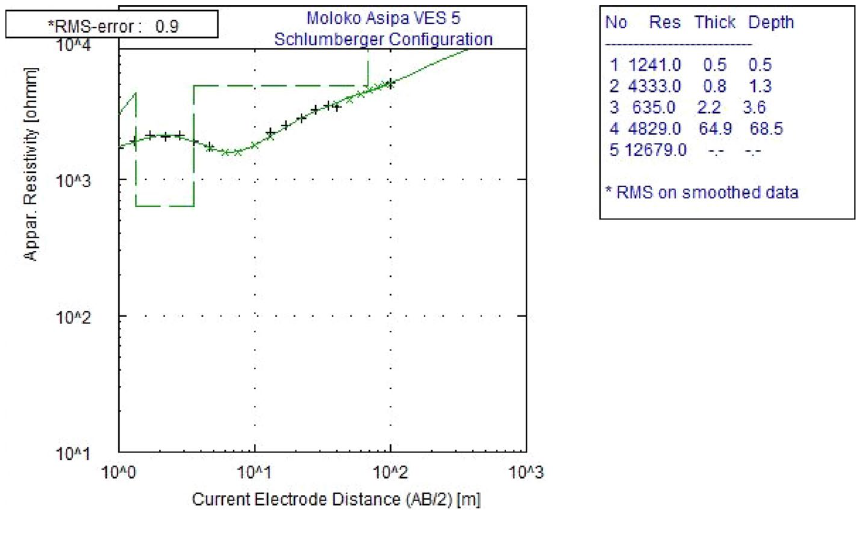
Fig. 15 Layer model interpreta- tion for VES